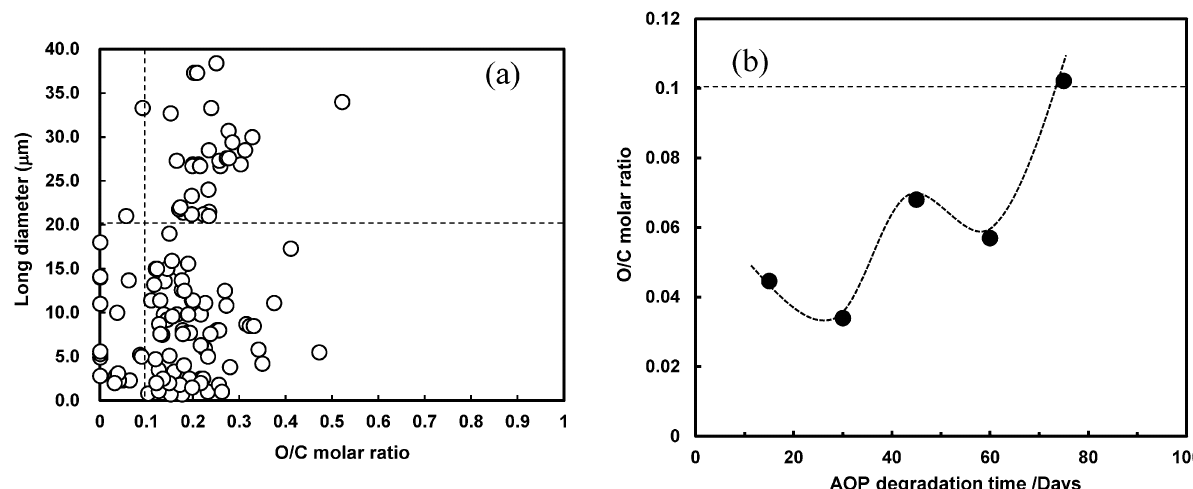
Figure 2. ( a ) Relationship between O/C molar ratio and long diameter (mm) of MP samples retrieved from the sea. ( b ) Relationship between AOP degradation time and O/C molar ratio AOP using a PP sample in distilled